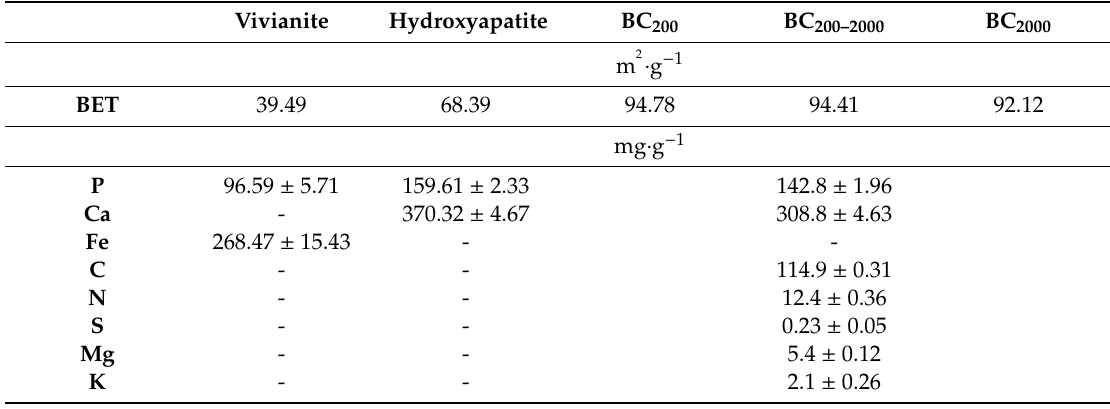
Table 2. Brunauer Emmett Teller (BET) specific surface area and elemental composition* of vivianite, hydroxyapatite, and bone char. Given are the mean and standard deviations (SD).